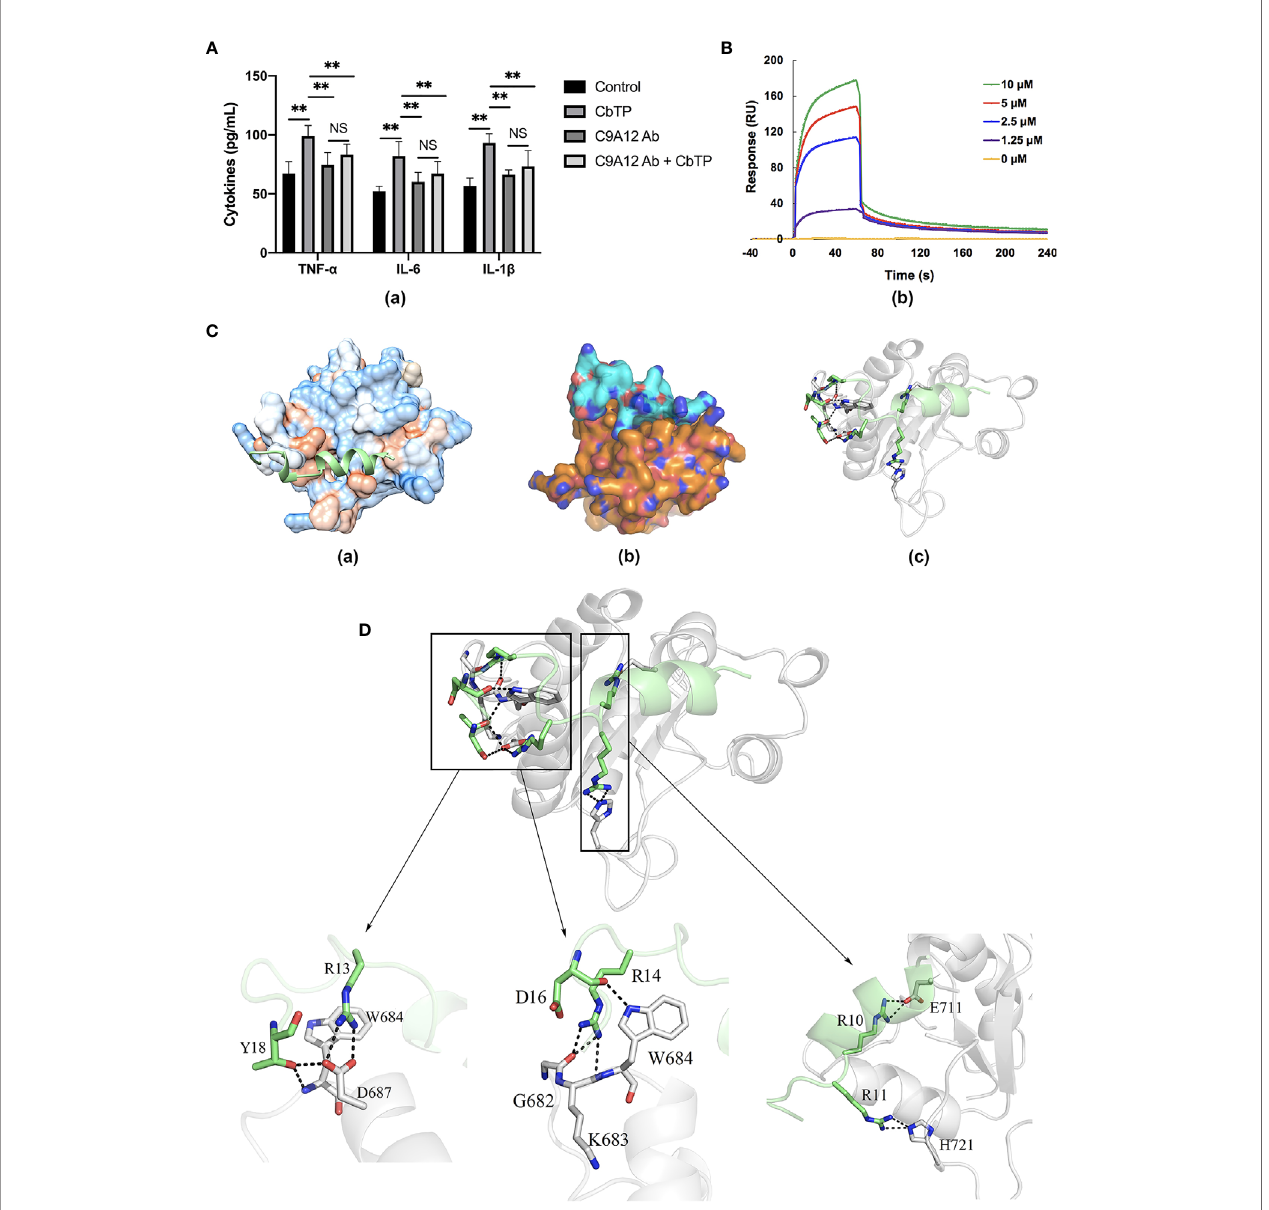
FIGURE 9 | CbTP interacts directly with TLR2 to activate TLR2 signaling. (A) RAW264.7 cells analyzed for cytokine quanti fi cation in the culture supernatants were treated with PBS or an anti-mouse TLR2 mAb (C9A12 Ab) for 1 h followed by the addition or no addition of 10 m g/mL CbTP peptide and further incubated for 24 h at 37°C. Levels of TNF- a , IL-6, and IL-1 b in the culture supernatant were determined by ELISA. NS: p > 0.05 and **p ≤ 0.01. (B) Speci fi c binding of CbTP to TLR2. TLR2 was immobilized on a sensor chip, and CbTP binding was analyzed by surface plasmon resonance. (C-c) Binding modes between TLR2 and CbTP. Modeled crystal structure of CbTP bound in the hydrophobic region of TLR2. Best scoring tertiary structure model generated from docking procedure depicted as (C-a) Hydrophobic surface (orange: hydrophobic, blue: hydrophilic). The peptide CbTP is shown in green. (C-b) Electronic binding surface of the TLR2/CbTP complex (orange: TLR2, cyan: CbTP). (C-c) Amino acids forming the binding interface (TLR2: gray; CbTP: green). (D) Illustration of key residues of CbTP in the TLR2 interface. Close-up views of the CbTP-occupied sites in TLR2 are displayed. The light gray ribbons represent TLR2 and the hydrogen bonds are shown as black dashes.